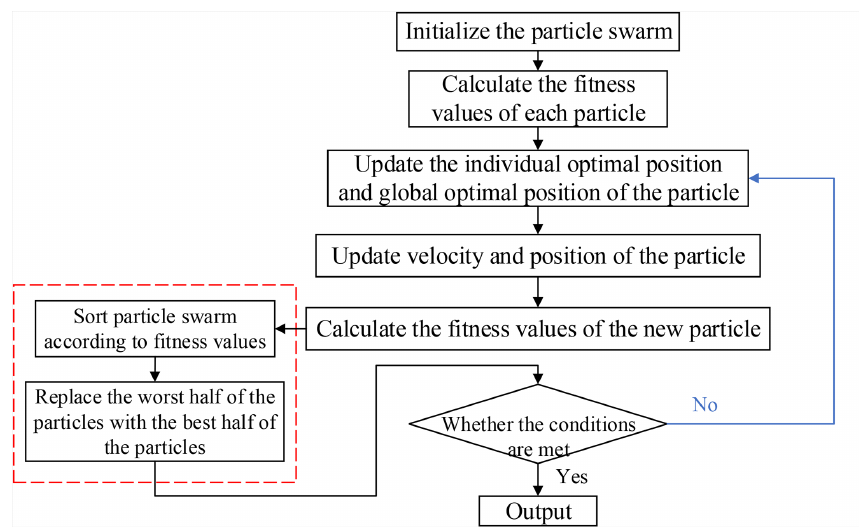
Figure 9. The flowchart of particle swarm optimization based on natural